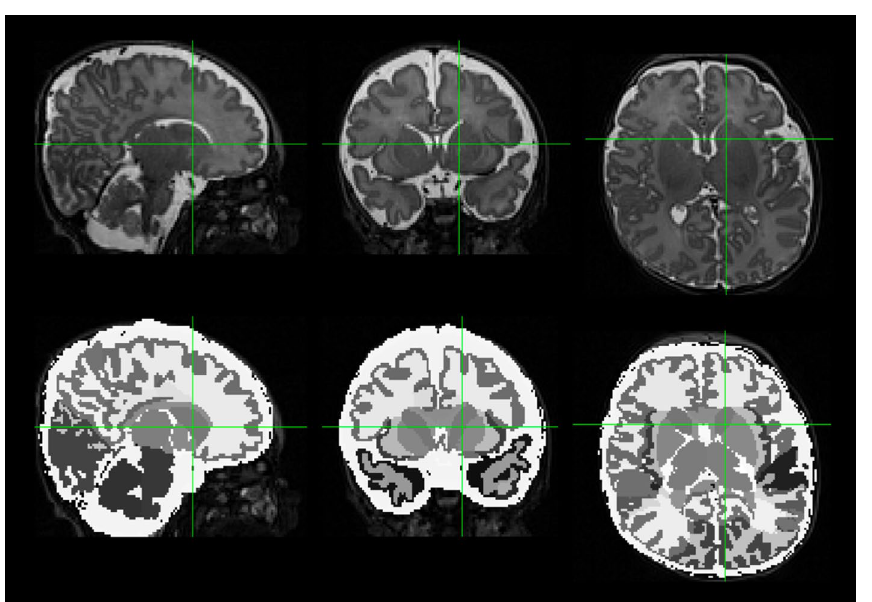
Figure 2. Mean Percent Difference in Cortical Metrics (Full-term to Very Preterm). Regional percent differences in adjusted group means for surface area (panel A), gyrification index (panel B), curvature of the white matter surface (panel C), and sulcal depth (panel D). For regions with significant differences between groups (after false discovery rate correction), percent difference values (VPT − FT)/FT * 100 are projected onto a representative subject brain from the very preterm group. These values have been corrected for postmenstrual age at MRI scan and total brain tissue volume. For each panel, Top row: right hemisphere; Bottom row: left